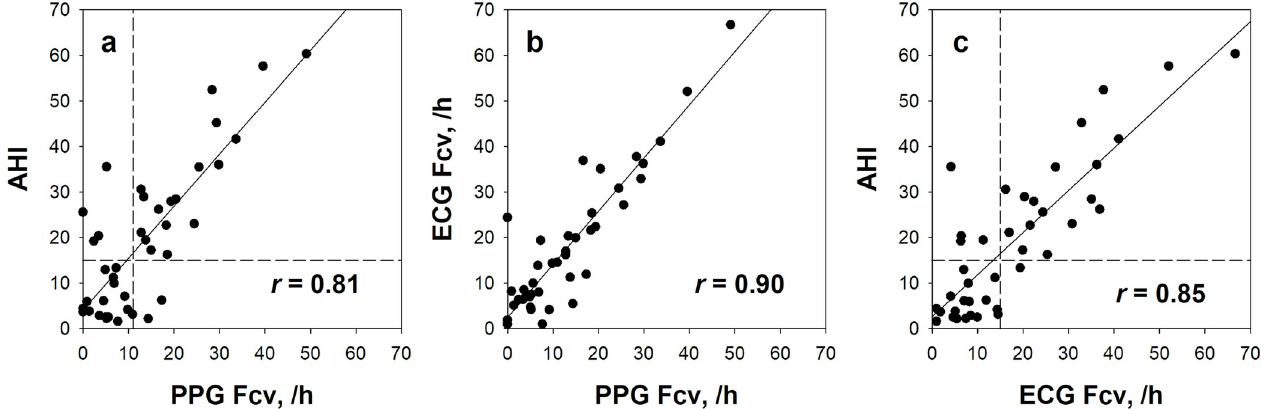
Fig 4. Relationships of PPG and ECG Fcv with AHI. In all panels a-c, the plots represent individual subjects. The solid line in each panel represents the linear regression line of the data for all subjects. Horizontal and vertical dashed lines in panels a and c represent the thresholds of 15 for AHI, 11 /h for PPG Fcv, and 15 /h for ECG Fcv,